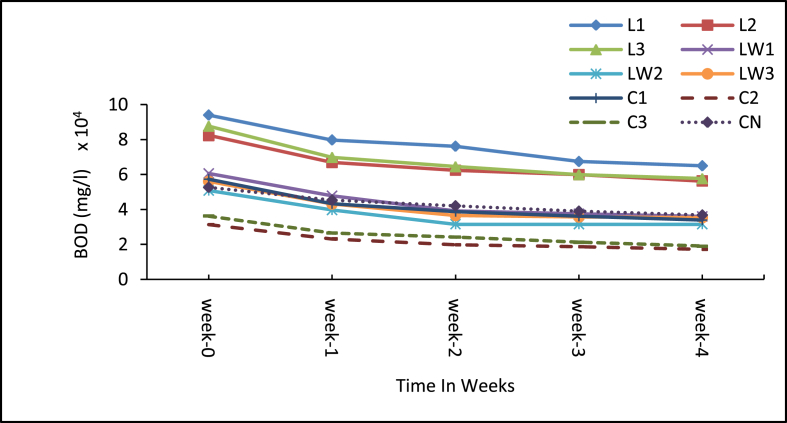
Mean BOD5 levels of treatment samples. Note: L1 = 25 mL stock LSEC, L2 = 50 mL stock LSEC, L3 = 75 mL stock LSEC, LW1 = 0.1% DF, LW2 = 0.5% DF, LW3 = 1% DF, C1 = 5 g calcium carbide, C2 = 8 g calcium carbide, C3 = 10 g calcium carbide, CN = control.